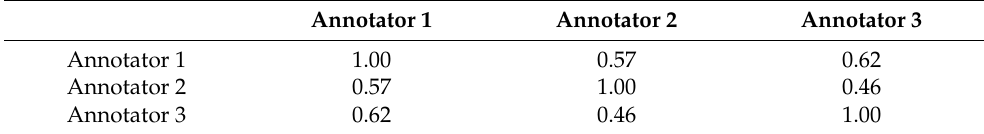
Table 1. The Pearson’s correlation among three annotators.